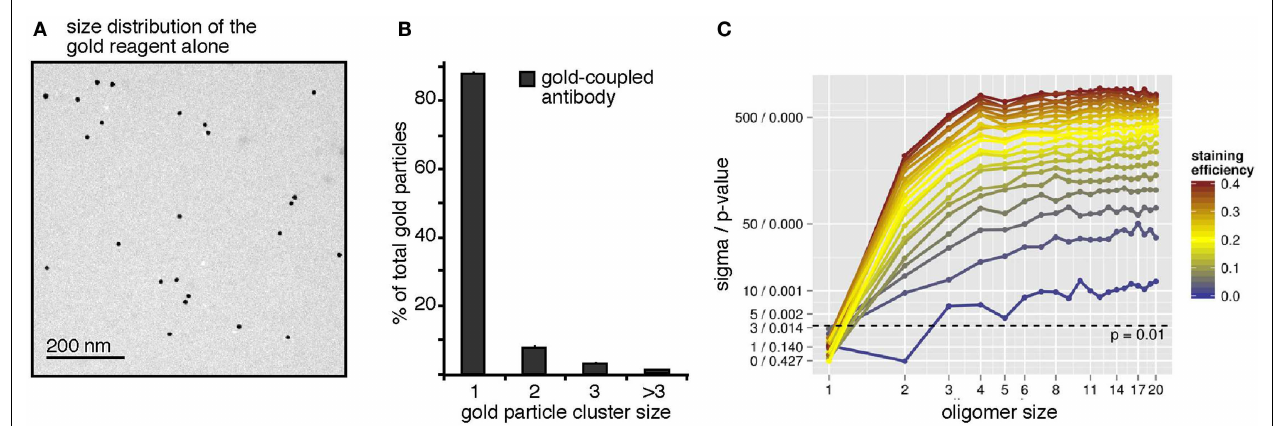
FIGURE 2 |The antibody-coupled gold-reagent is mainly monomeric . (A) The gold-reagent alone was adsorbed onto collodion/carbon-coated EM grids and analyzed byTEM. (B) Analysis of the clustering of 2041 gold particles alone showed 88% monomeric gold particles, 8% of gold particles as close as dimers, 3% were counted as trimers, and 1% as clusters of larger sizes. (C) The gold-reagent cluster size distribution was re-evaluated by our workflow, interpreting the cluster counts as receptor